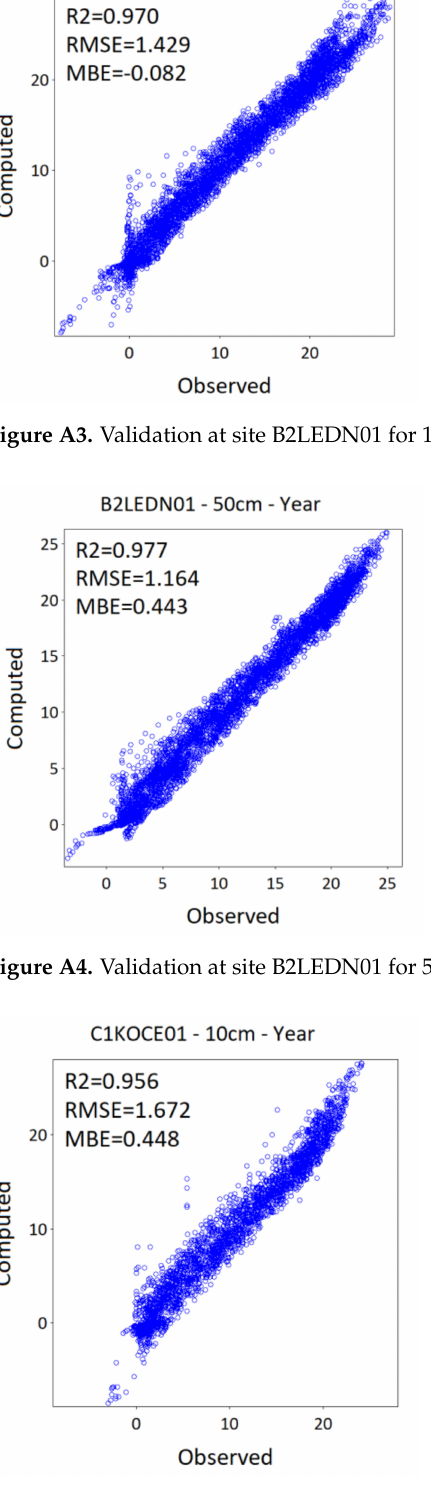
Figure A5. Validation at site C1KOCE01 for 10 cm soil